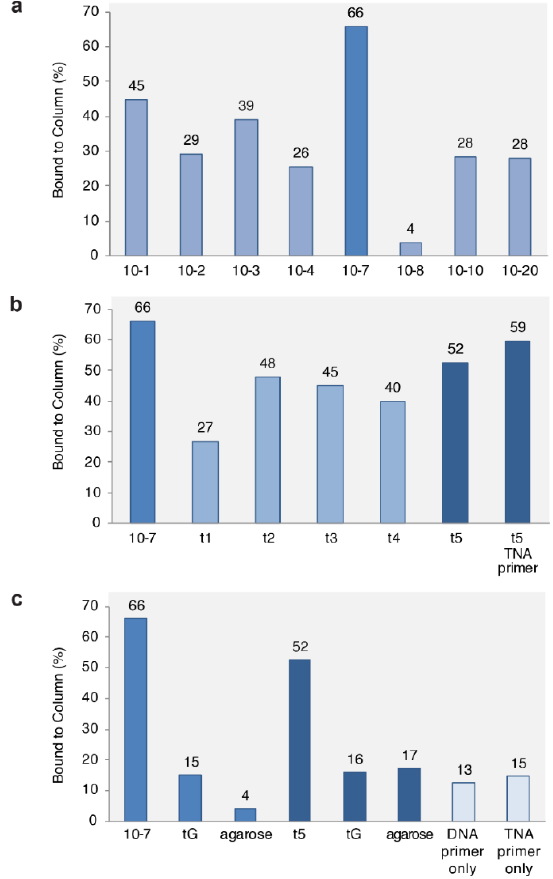
Figure 2. ATP binding activity of in vitro selected TNA aptamers. TNA aptamers tagged with an IR680 dye were evaluated for their ability bind to and elute from ATP-derivatized agarose beads. ( a ) Activity screen of eight unique ATP binding aptamers isolated after 10 rounds of in vitro selection and amplification. ( b ) Truncation analysis of aptamer 10-7 using the technique of 5′ and 3′ end-mapping deletion analysis. ( c ) Binding controls evaluating the contribution of the 7-phenyl-guanine base to the binding activity of the full-length (10-7) and truncated (t5) versions of the TNA aptamer. Other controls included binding assays to underivatized agarose beads as well as the DNA and TNA primer only sequences to ATP derivatized agarose.